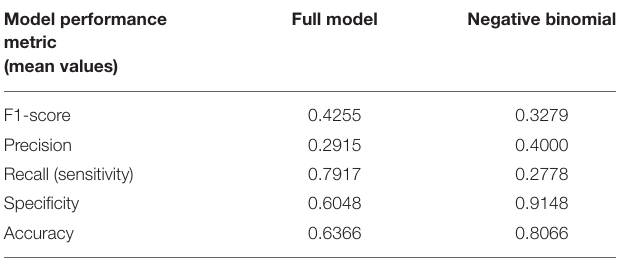
TABLE 4 | Detailed comparison of performance metrics: full model vs. negative binomial